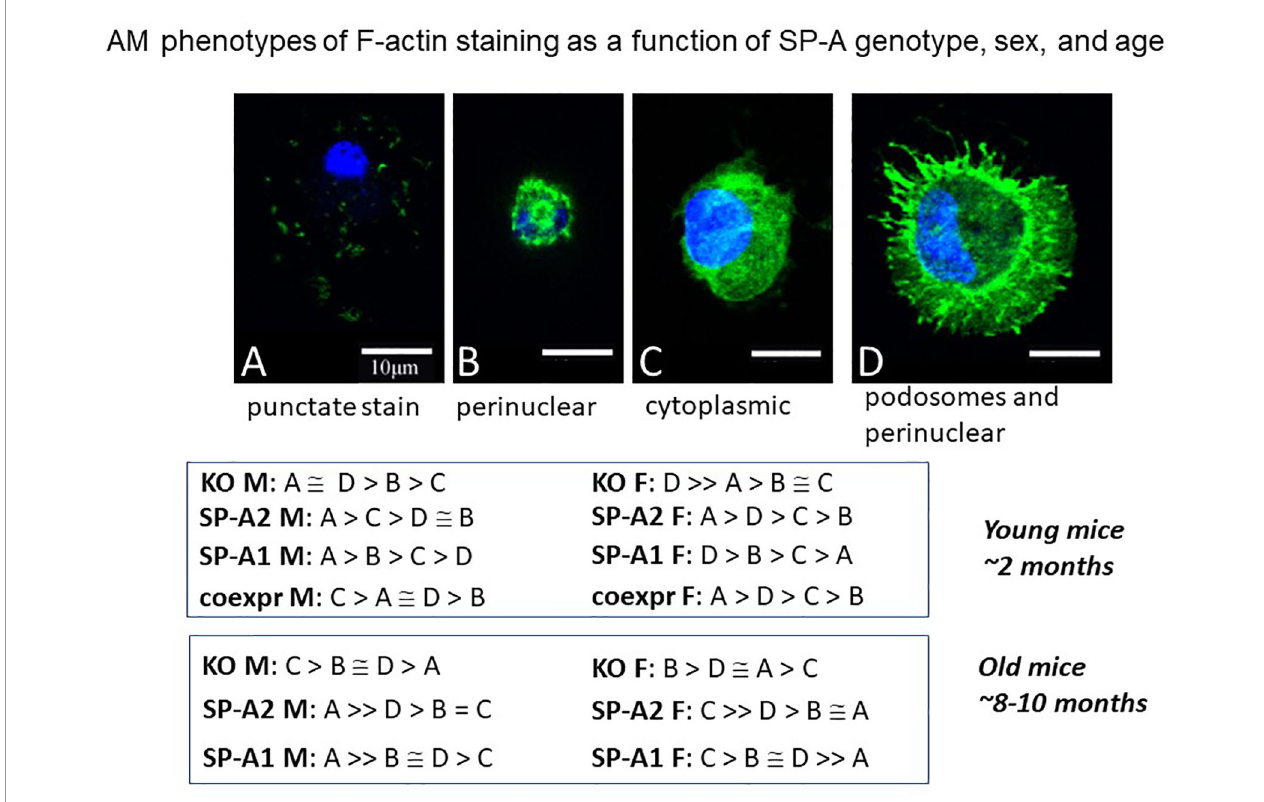
FIGURE 10 | AM phenotypes of F-actin staining as a function of SP-A genotype, sex, and age. The fl uorescence pattern of four types of F-actin staining is shown. The F-actin stain in (A) is punctate i.e. scattered cytoplasmic, in (B) perinuclear, in (C) diffuse in cytoplasm, and in (D) cortical with cytoplasmic protrusions (podosomes) and perinuclear. Cells were fi xed, permeabilized and stained with Alexa Fluor 488-conjugated phalloidin. Images were obtained with a Leica SP8 AOBS laser scanning confocal system with software-adjusted detection spectra to avoid bleed through of the signal as described in detail by Tsotakos et al. (116). The relative frequency of these types in young and old mice are shown as a function of SP-A genotype and